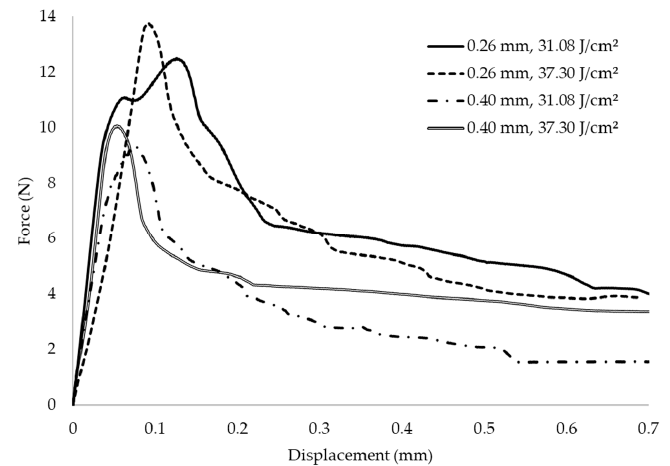
Figure 12. Force-displacement curves obtained from lap shear tests.